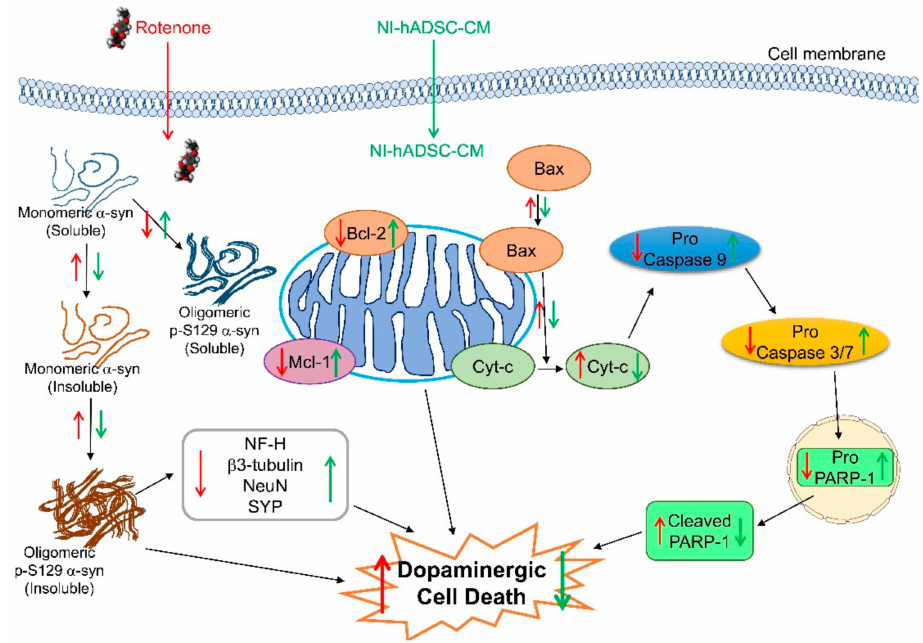
Figure 8. Diagrammatic representation of various activities of NI-hADSC-CM in the ROT-induced PD-like model. The downward arrows ( ↓ ) denote inhibitions, and the upward arrows ( ↑ ) denote stimulation by ROT (red) and NI-hADSC- CM